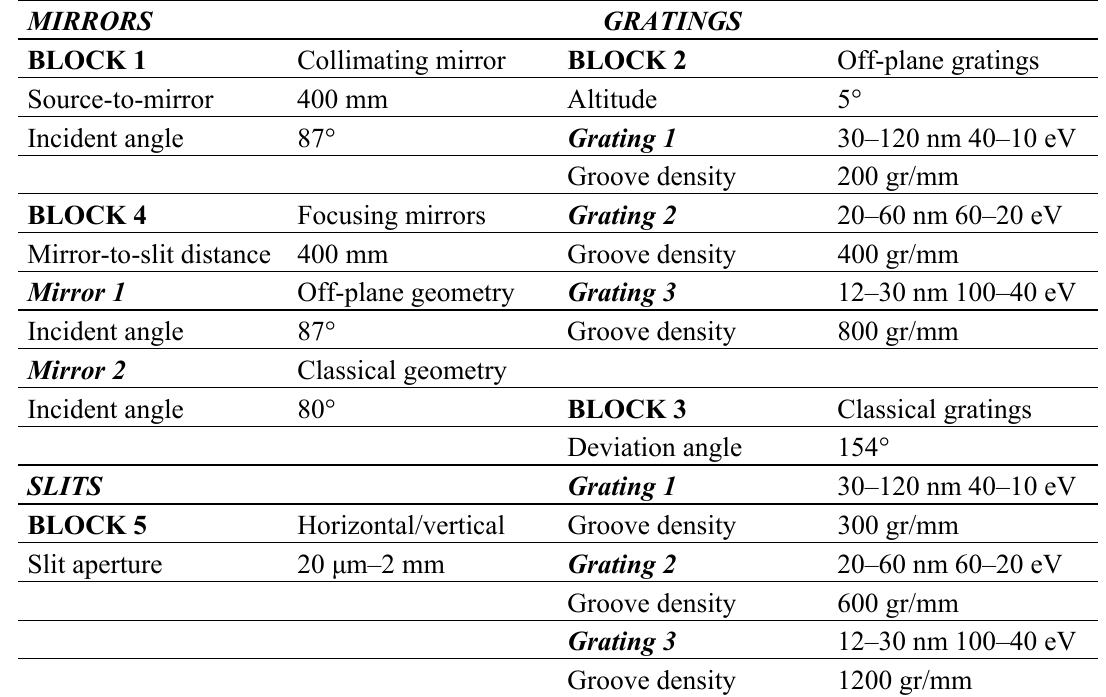
Table 2. Parameters of the